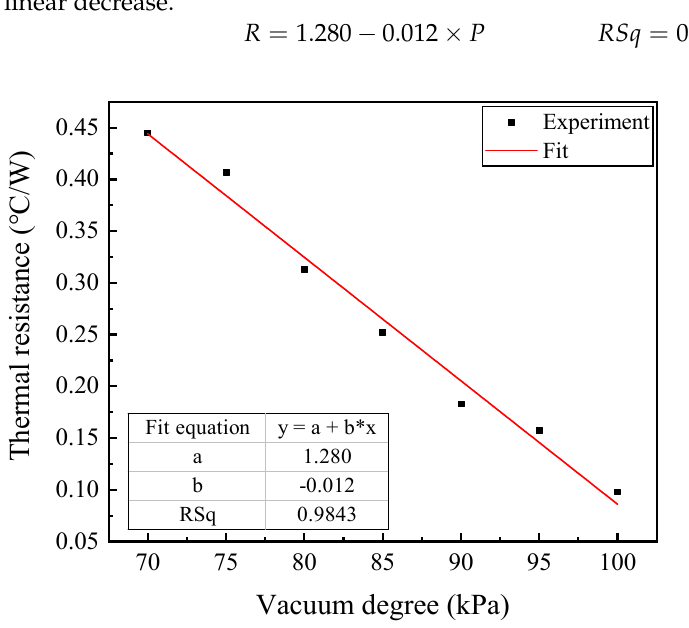
Figure 5. Thermal resistance versus vacuum degree of experiment and fit.